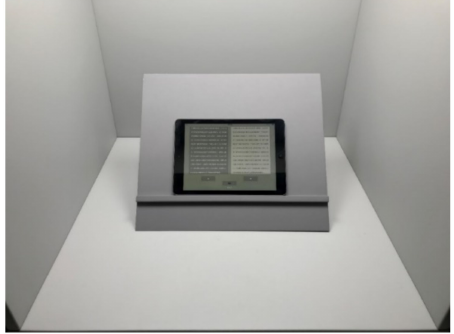
Figure 1. Viewing environment.